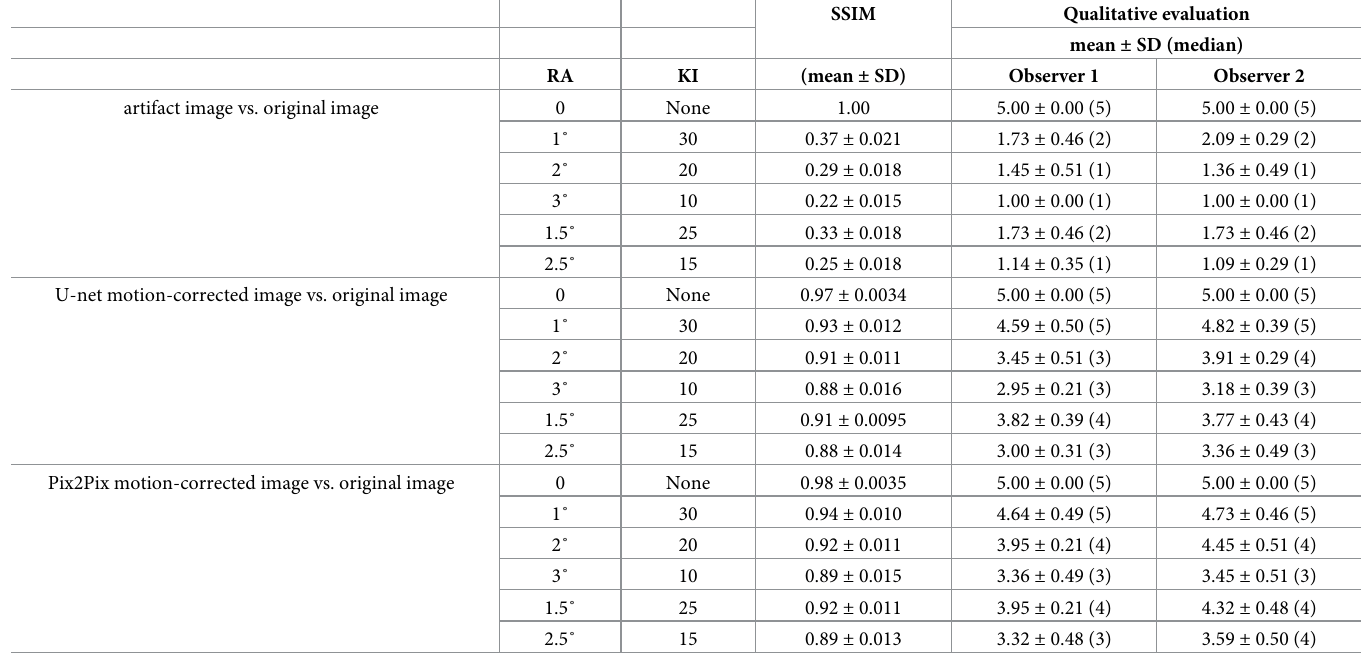
Table 2. Results of SSIM analysis and qualitative evaluation when set to trained rotation angles and k-space intervals.